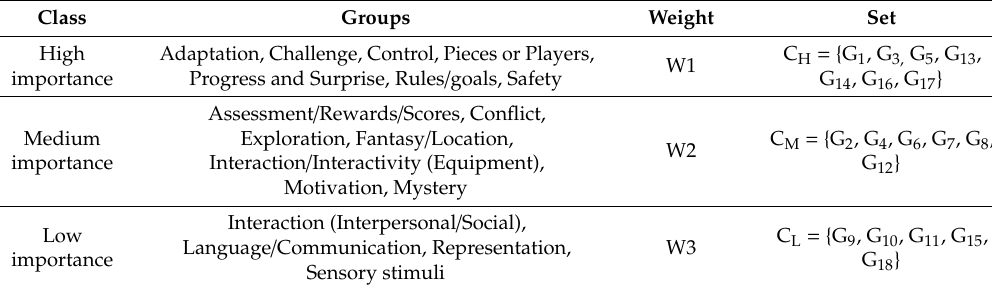
Table 3. Classification of feature groups based on their correlation and importance. Class Groups Weight